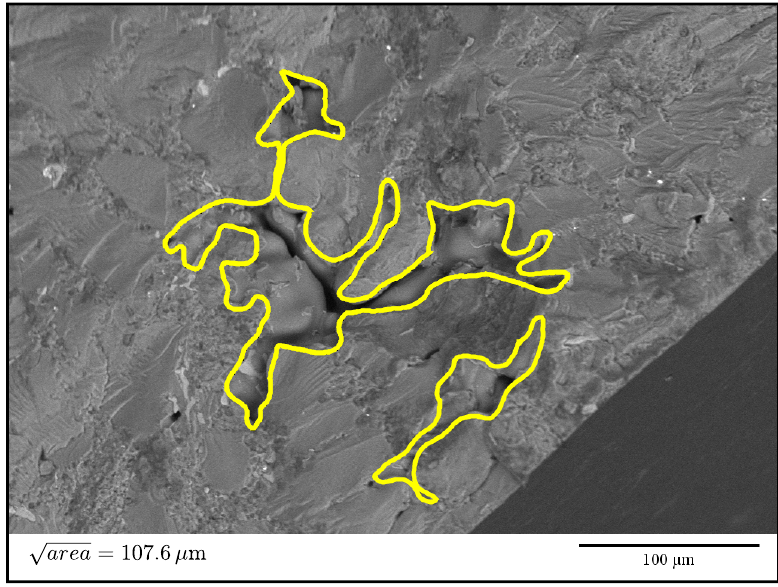
Figure 9. Fracture initiating defect at specimen A.